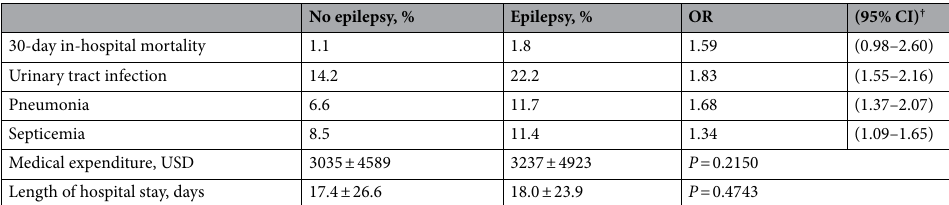
Table 4. Adverse outcomes after diabetes admission in patients with epilepsy*. CI confidence interval, OR odds ratio, USD United States dollars. *New-diagnosed diabetes after epilepsy. † Adjusted for all covariates listed in Table